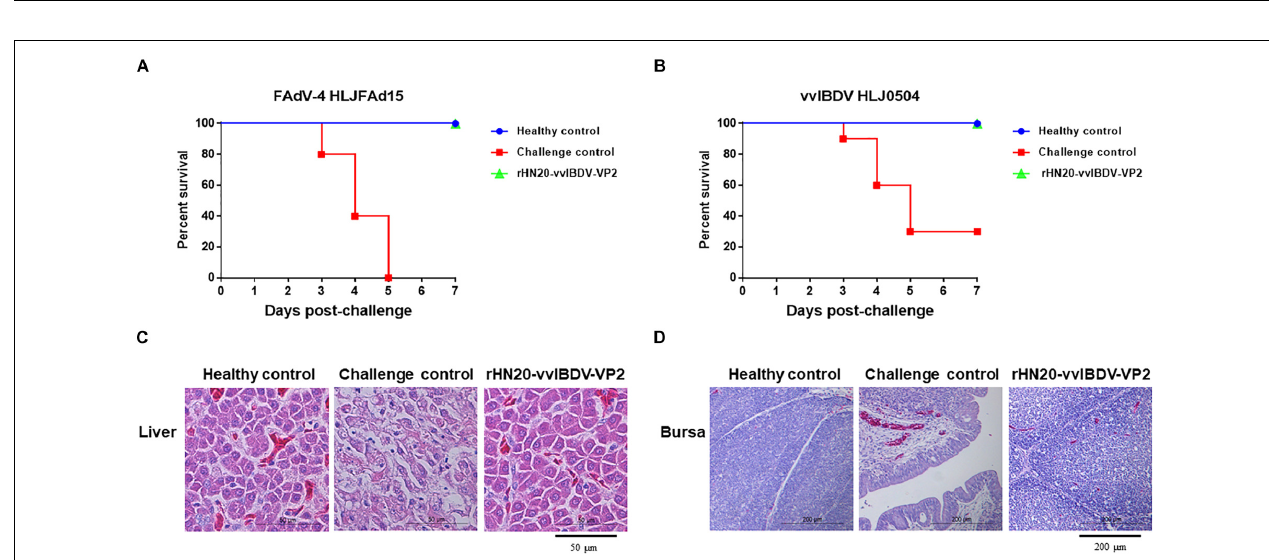
FIGURE 7 | Neutralizing antibody titers of live rHN20-vvIBDV-VP2. Neutralizing antibody titers to (A) FAdV-4 and (B) IBDV in two-week-old SPF chickens intramuscularly injected with live rHN20-vvIBDV-VP. **, ***, ****, significance at P < 0.01, P < 0.001, and P < 0.0001, respectively; ns, no significance.